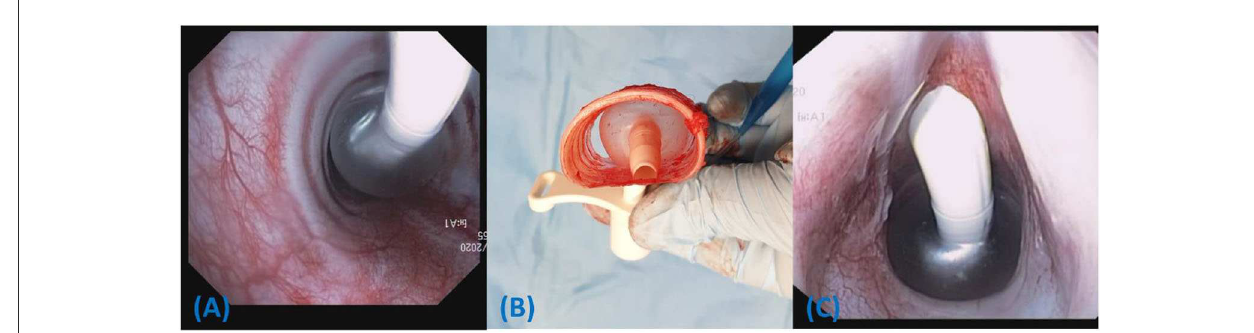
FIGURE6 Ventral is toward the top of the image. (A) The Melker tube is shown in situ in cadaver 2. Air can escape lateral to the cuff, particularly in tracheas with higher lateral to dorsoventral ratios. (B) The Melker tube is shown in a dissected portion of the trachea from cadaver 3. Contact on the dorsal and ventral trachea occurs first when inflated to a pressure of 20cm H 2 O. (C) Hyperinflated tube cuff from Melker tube, pulled proximally to lodge at the caudal cricoid ring in Cadaver 1. An effective seal can be observed as the spherical cuff conforms to the circular boundary of the caudal cricoid ring.